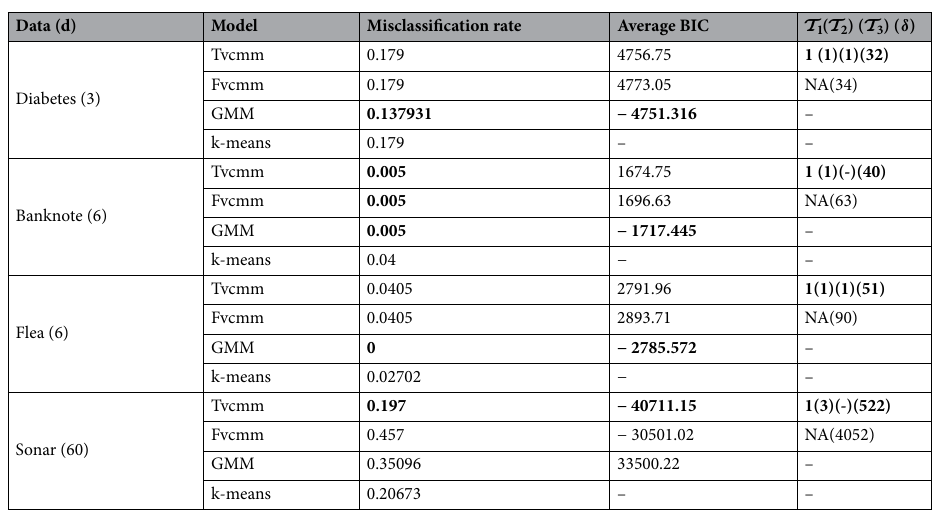
Table 4. The summary of the performance of the Tvcmm and Fvcmm, GMM, and k-means methods fitted to the simulated data with 500 observations. Tvcmm, Fvcmm, GMM, and k-means refer to the truncated vine copula mixture model, full vine copula mixture model, Gaussian mixture model and the k-means method, respectively. d , T 1 , T 2 , T 3 , and δ refer to the data dimension (without the class variable), the truncation level of the first cluster, the truncation level of the second cluster, the truncation level of the third cluster, and the total number of the estimated model parameters, respectively. Significant values are in